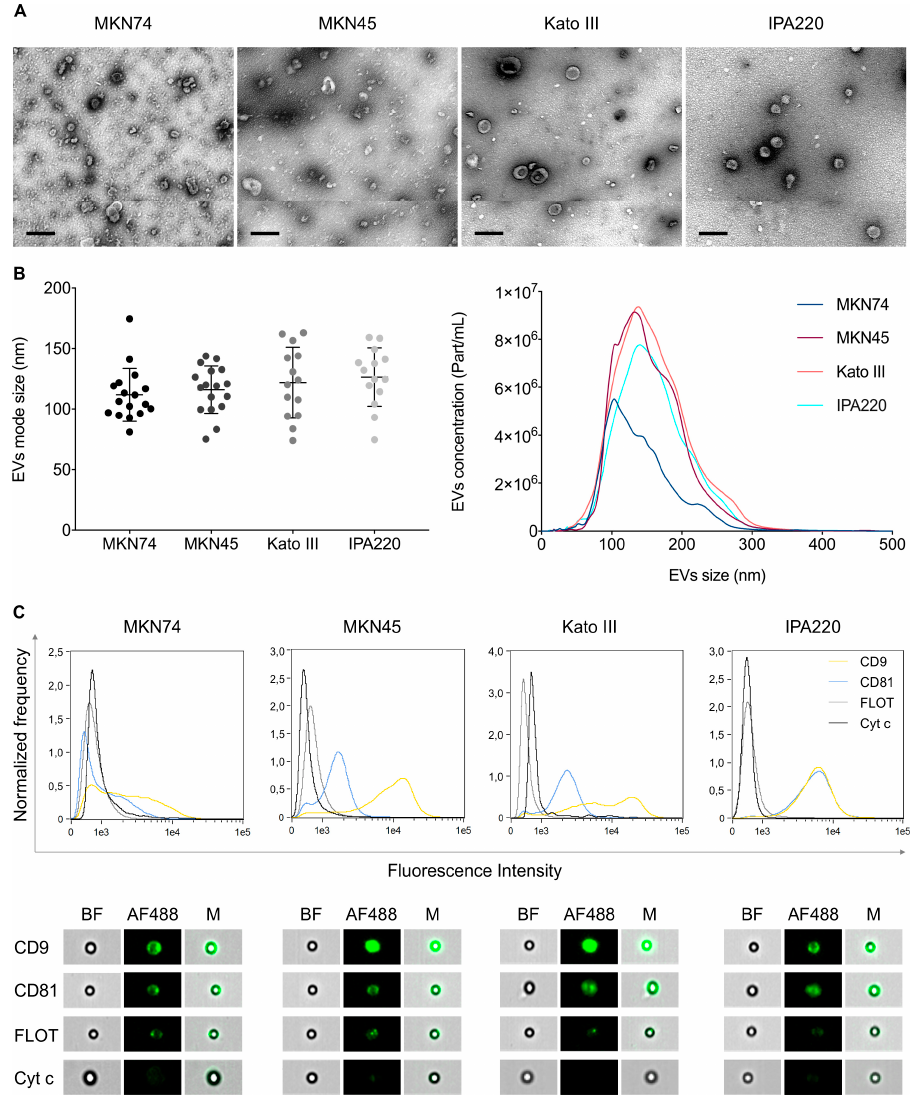
Figure 3. Characterization of EVs secreted by MKN74, MKN45, Kato III, and IPA220 GC cell lines. ( A ) Representative electron microscopy images of EVs isolated from GC cells. Scale bars: 200 nm; ( B ) NTA of isolated EVs with mode size distribution (left) and particle concentration (right). Graphs represent the mean ± standard deviation of at least 14 biological replicates; ( C ) detection of CD9, CD81, Flotillin-1, and Cytochrome C (negative control) by imaging flow cytometry. Distribution and representative images of the intensity of fluorescence detected for each marker in three biological replicates. Bright-field images (BF) show beads to which EVs were coupled, fluorescence images (AF488) show EVs labeled with specific markers, and merged images (M) show labeled EVs coupled to beads.